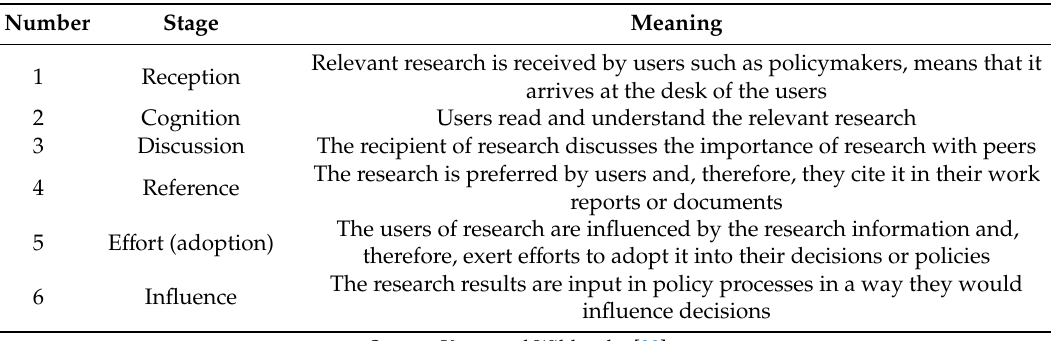
Table 1. Stages of knowledge